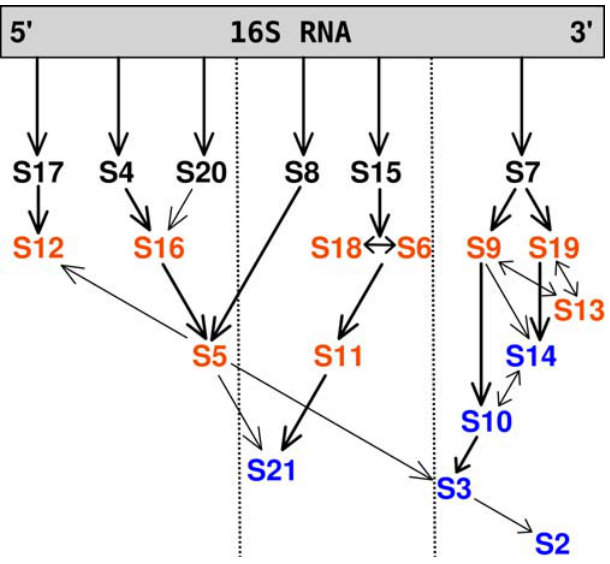
Figure 1. The 30S Subunit In Vitro Experimental Assembly Map for E. coli The primary, secondary and tertiary binding proteins are shown in black, orange, and blue, respectively. Arrows indicate facilitating effect of binding of one protein on another. Adapted from the review of Culver [6] based on the work of the Nomura Laboratory [4,5]. DOI: